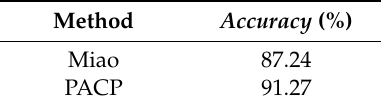
Figure 7. Comparison of unadjusted features and PACP.